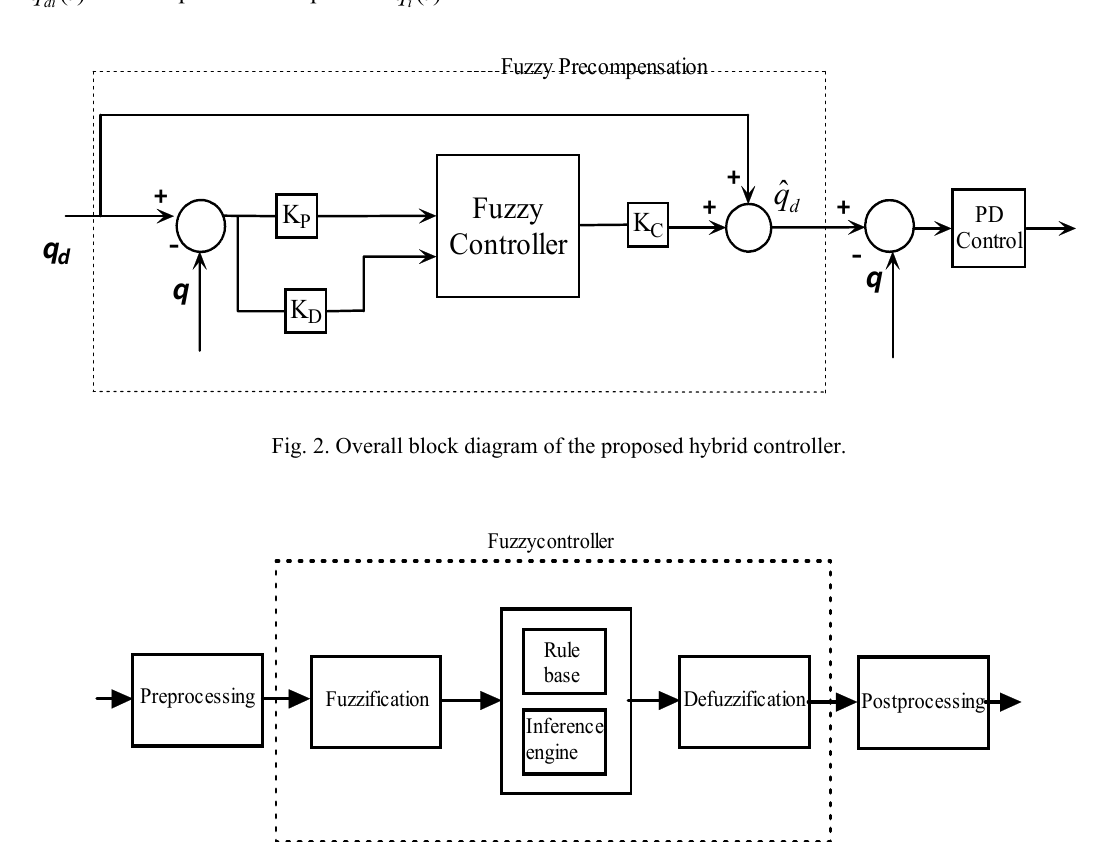
Fig. 3. Structure of Fuzzy